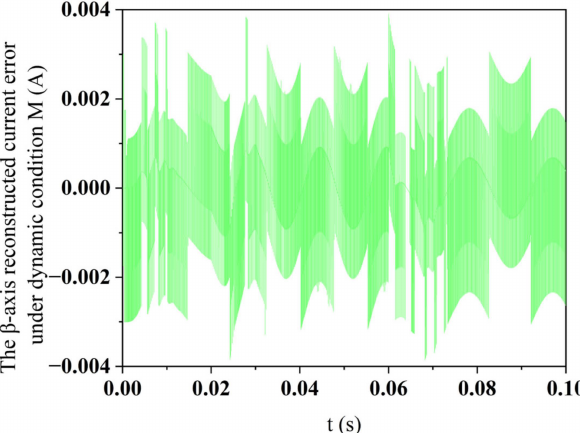
Figure 10. The β -axis reconstructed the current error under dynamic condition M.